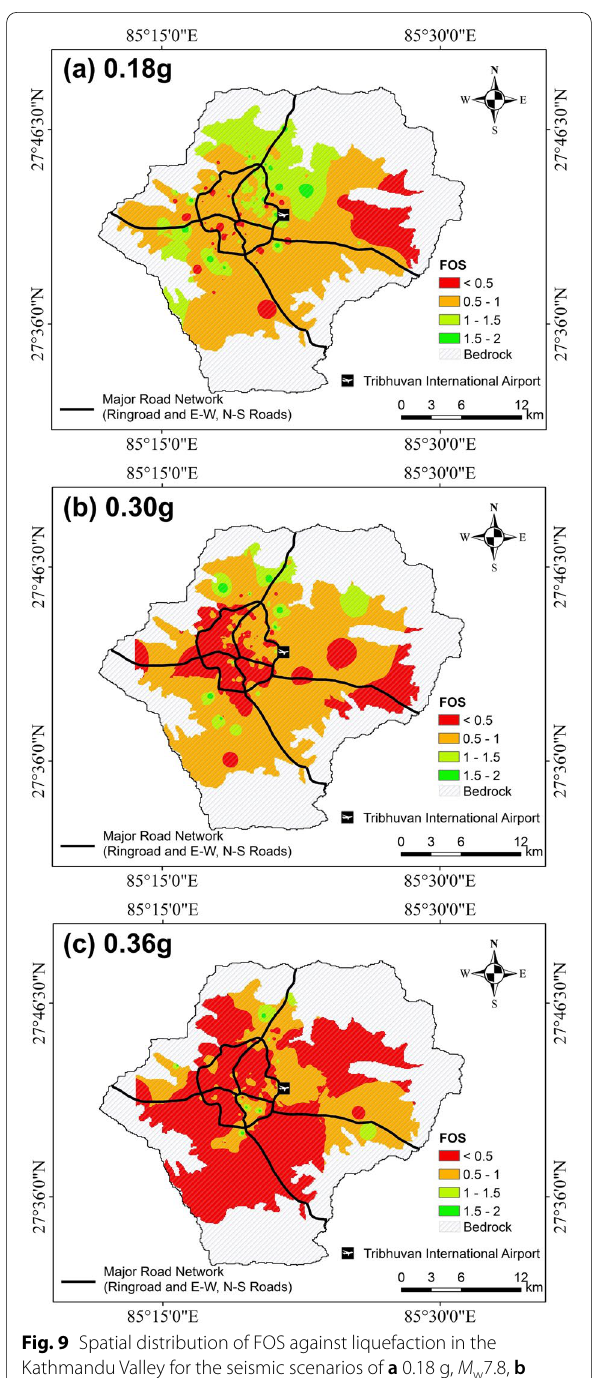
Fig. 9 Spatial distribution of FOS against liquefaction in the Kathmandu Valley for the seismic scenarios of a 0.18 g, M w 7.8, b 0.30 g, M w 8.0, c 0.36 g, M w 8.4 based on Idriss and Boulanger